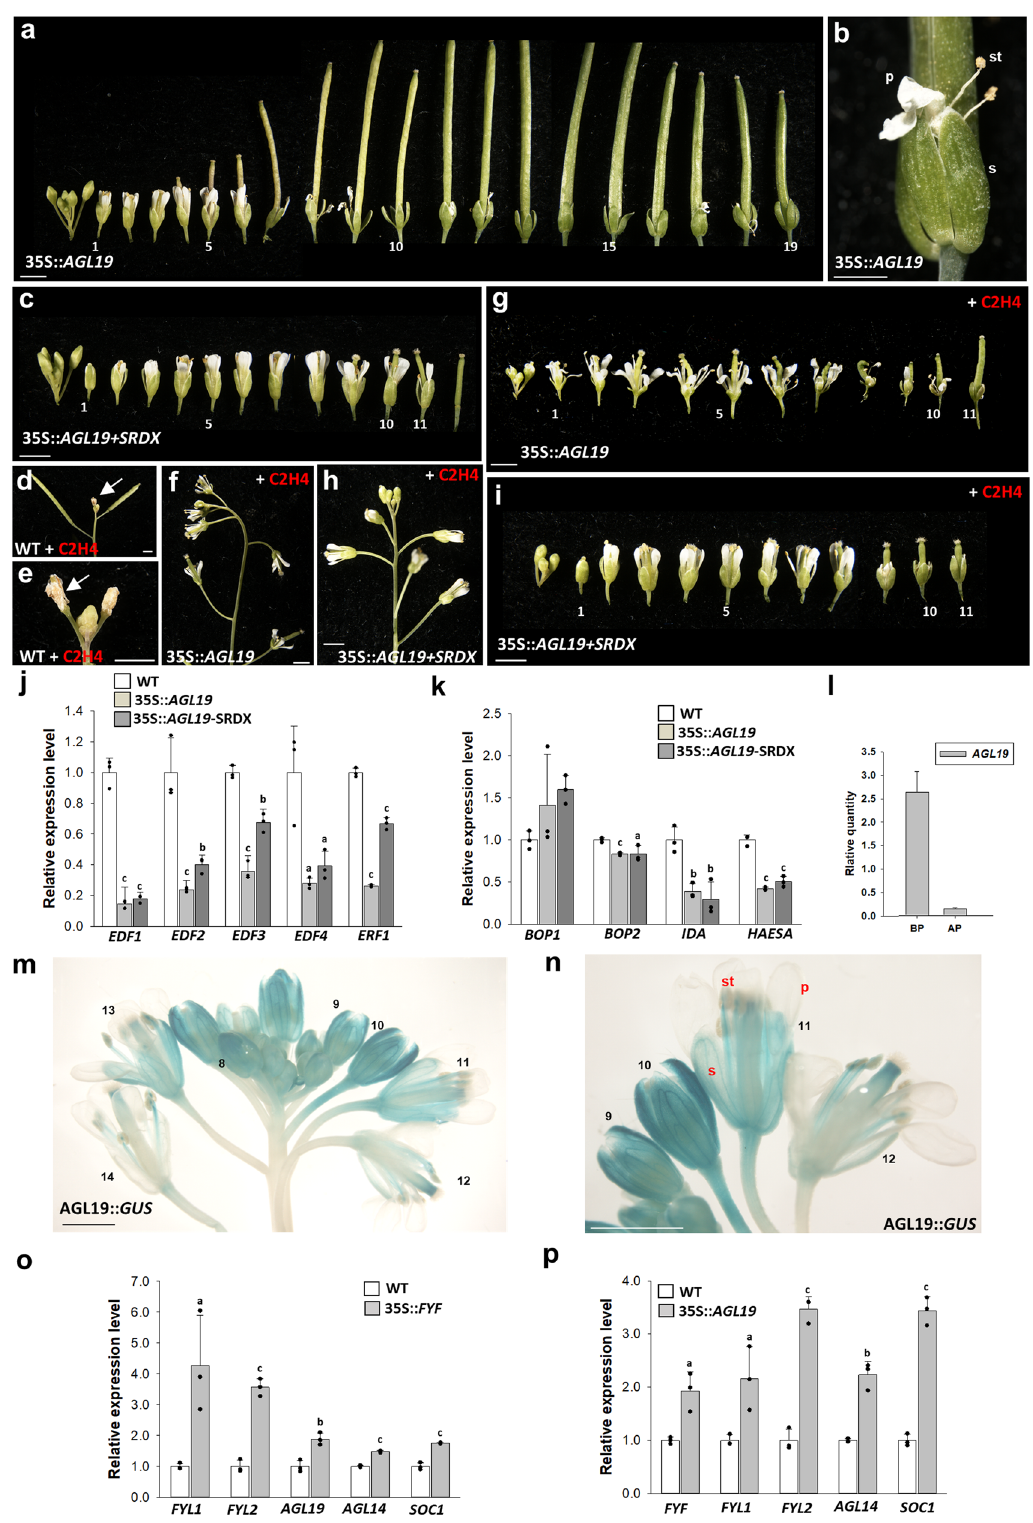
fl ower senescence (Fig. 5a). Although AGL19/14 and SOC1 were found to be involved in regulating fl ower senescence, similar to FYF/FYL2, they seemed to perform their function in a different way in terms of fi nding interacting partners to form functional complexes. For example, FYF/FYL1/FYL2 can interact suf fi ciently with AGL6/SEP1, whereas AGL19/14/SOC1 can not interact with AGL6/SEP1. This fi nding indicated that the